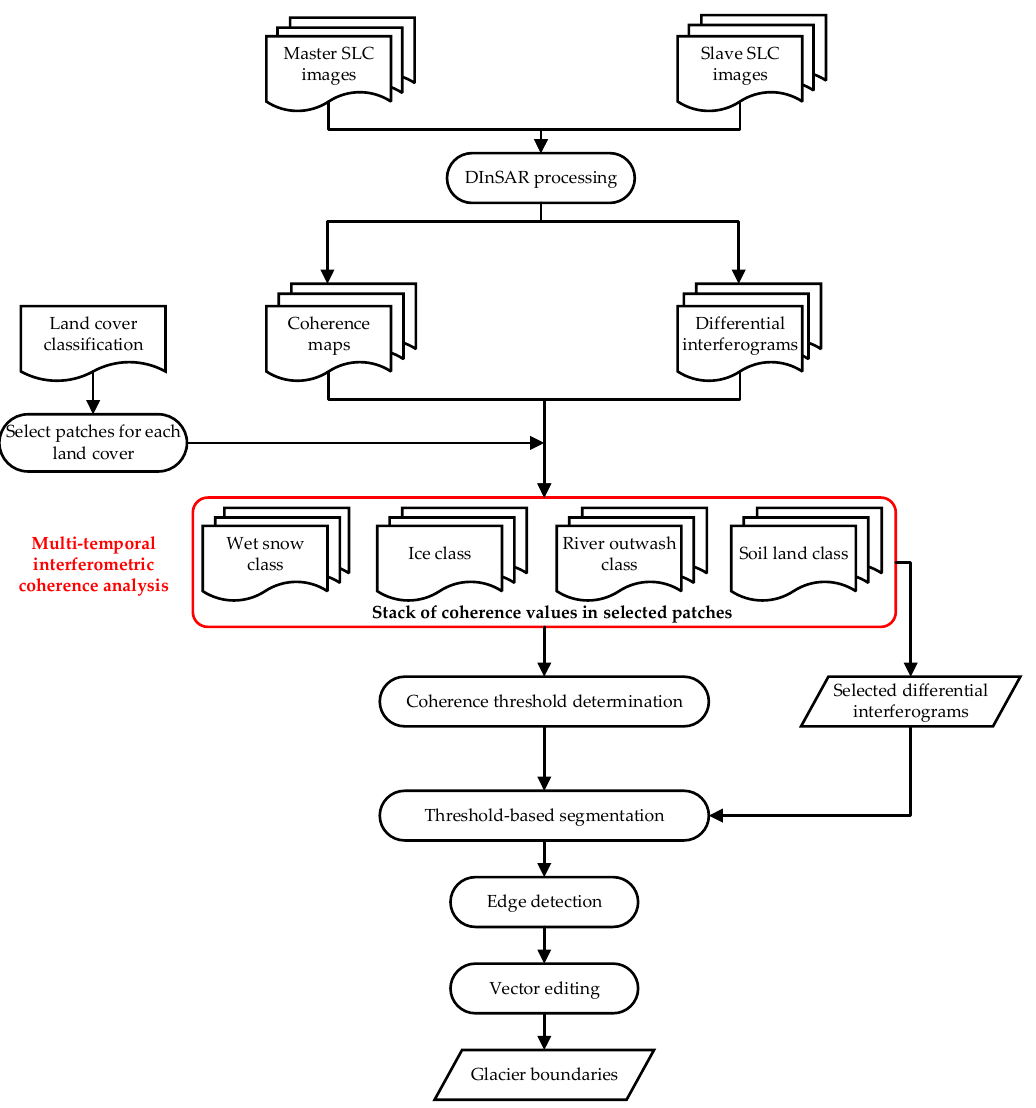
Figure 5. Flowchart for extracting the DDG glacier boundaries with multi-temporal interferometric coherence estimation. SLC: single look complex.